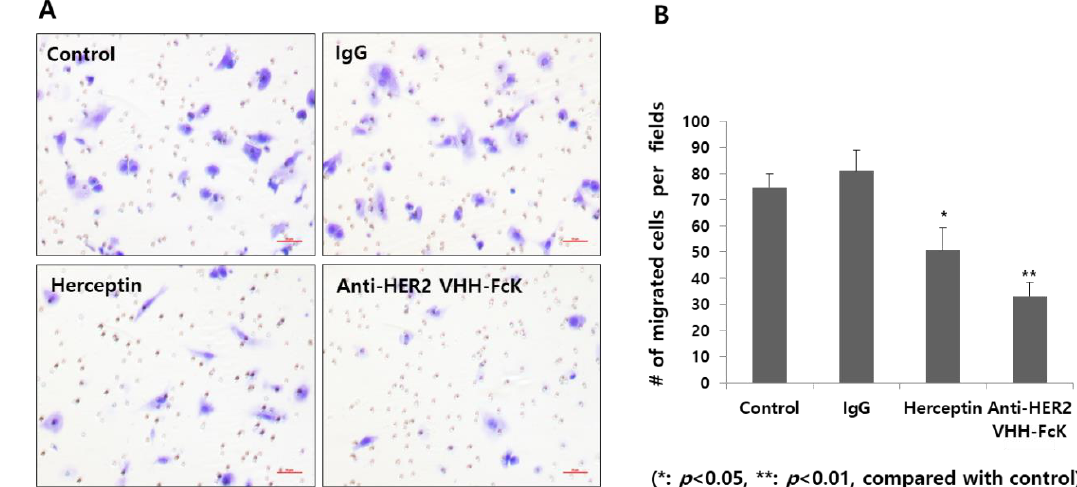
Figure 5. Migration assay for cells treated with the plant-derived anti-HER2 VHH FcK and Herceptin. ( A ) Microscopic observation of the migratory cells treated with 1 × PBS (negative control), nonspecific IgG (negative control), Herceptin (positive control), and plant-derived anti-HER2 VHH FcK. ( B ) Quantified cell number per field from microscopic observation (A). Scale bar (red) represents 50 μm (A).